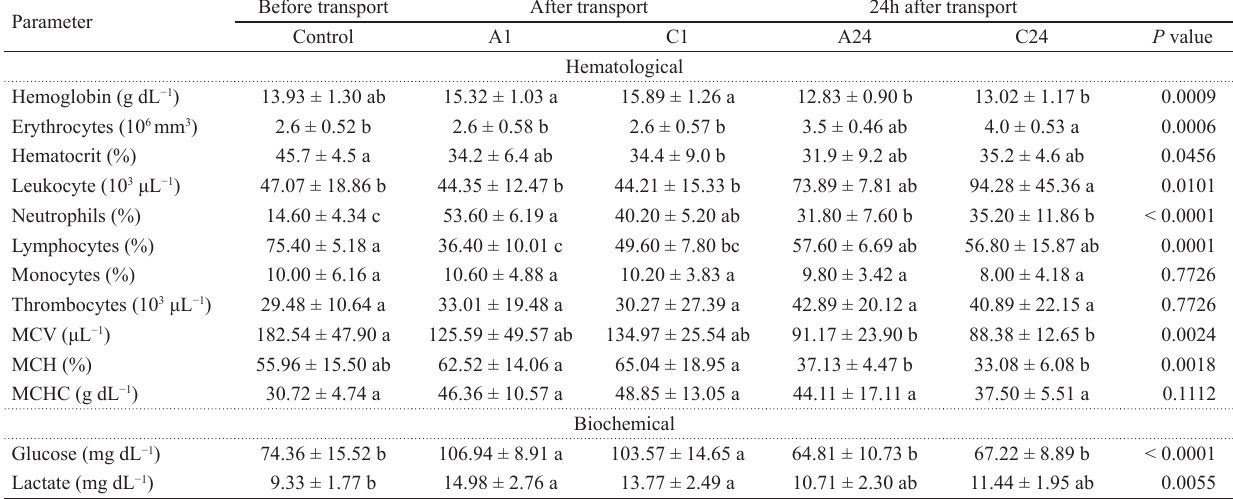
Fig. 1. Photomicrographs of a peripheral blood smear of Lutjanus jocu showing a corresponding sequence of images: a. Mature Erythrocyte (ME); b. Immature Erythrocyte (IE); c. Thrombocyte (T); d. Neutrophil (N); e. Lymphocyte (L); and f. Monocyte (M). Scale bars = 10 μm. Tab. 1. Biochemical and hematological parameters of Lutjanus jocu . Mean values ± SEM. Different letter (a, b or c) indicates significant differences (p<0.05) between fish groups. Control: fish collected in the cage prior to transport; A1: collection 1 h after transport to the laboratory with anesthetic; C1: collection 1 h after transport to the laboratory without anesthetic; A24: collection after 24 h in the laboratory of the fish transported with anesthetic; C24: collection after 24 h in laboratory of fish transported without